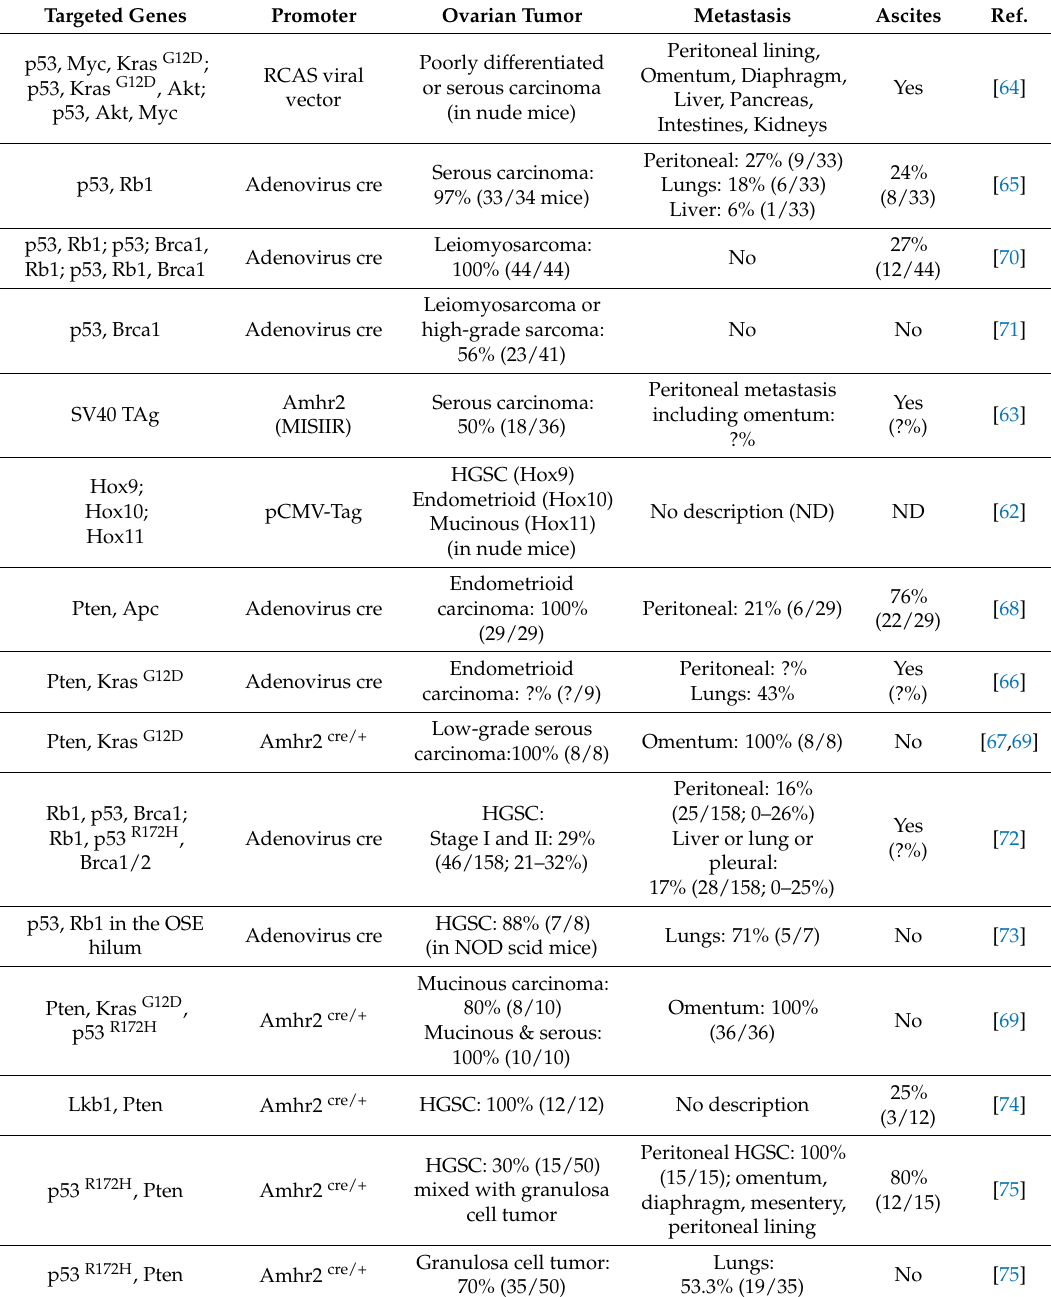
Table 1. Mouse models of ovarian cancer: ovarian